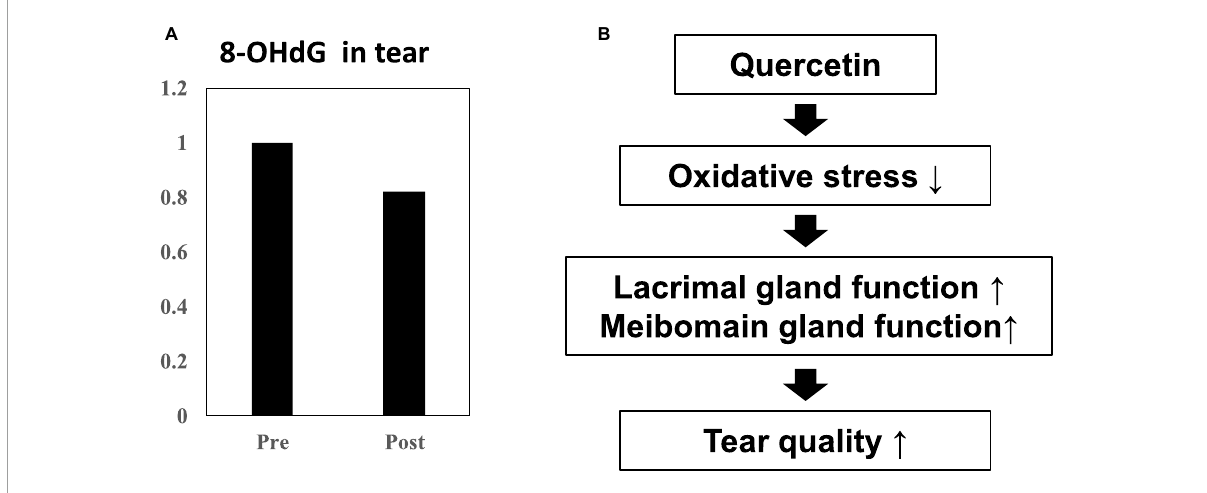
FIGURE6 Effect of quercetin supplementation on 8-OHdG, a by-product of oxidative stress, measured in tears from healthy volunteers. (A) Tear samples were collected before and after intake ( n = 4). Relative 8-OHdG levels normalized to before onion intake in tear. Ingestion of high dose quercetin in onion powder decreased the level of the oxidative stress marker 8-OHdG in tear. (B) Scheme of improvement in tear film stability. The distribution of quercetin and its metabolite shifted from serum to tear following onion intake. Induction of anti-oxidant proteins such